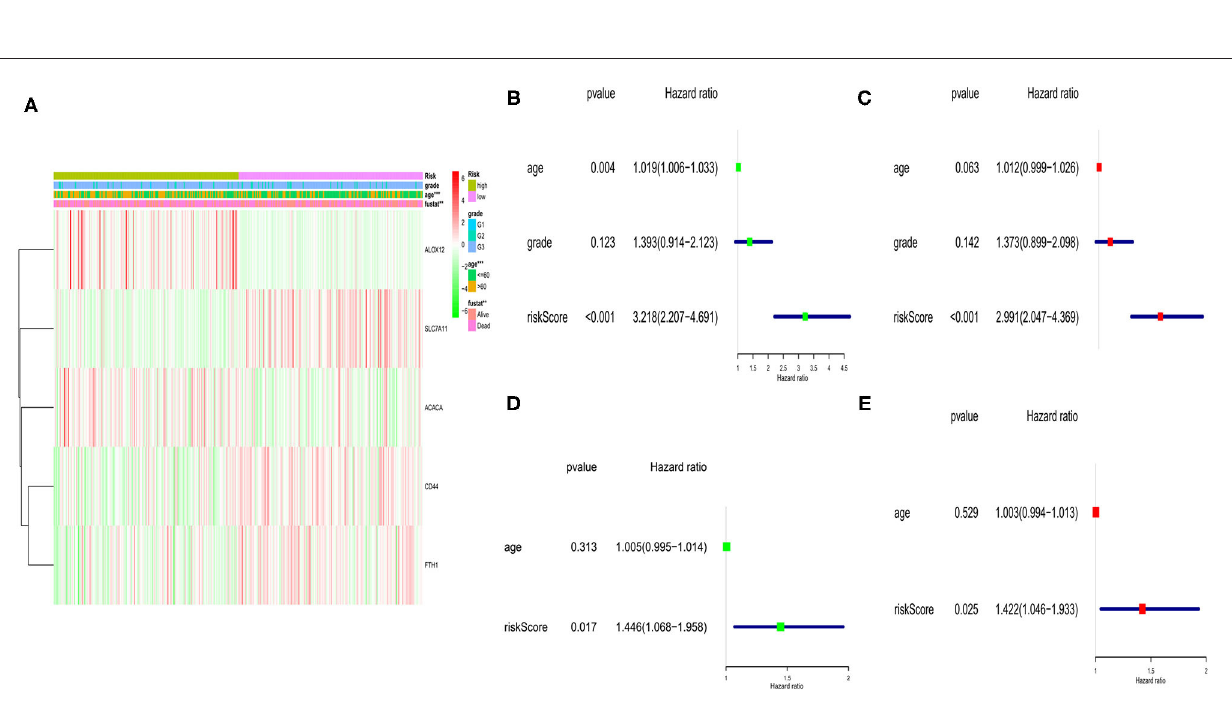
FIGURE 5 | Univariate and multivariate Cox regression analyses of OS in TCGA and GEO cohort. (A) Heatmap and clinicopathologic features of the 5 ferroptosis-related genes. (B) Univariate analysis for TCGA cohort. (C) Multivariate analysis for TCGA cohort. (D) Univariate analysis for GEO cohort. (E) Multivariate analysis for GEO